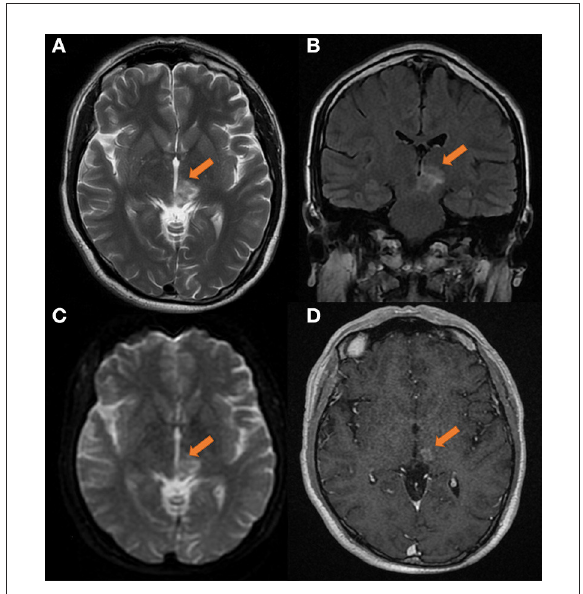
FIGURE2 Head MRI on 2019-09-03, compared with the anterior film (2019-08-14). (A) T2 transverse view: patchy medium and high signal masses can be seen in the left thalamus and pons, with smaller range and unclear edge. (B) T2 FLAAR lesions showed moderate and slightly high signal intensity. (C) DWI showed high signal intensity. (D) Transverse enhanced: the degree of enhancement of the lesions was less than before, showing nodular appearance, and no obvious necrosis was found in the lesions. The size of lesions was about 20 × 16 ×